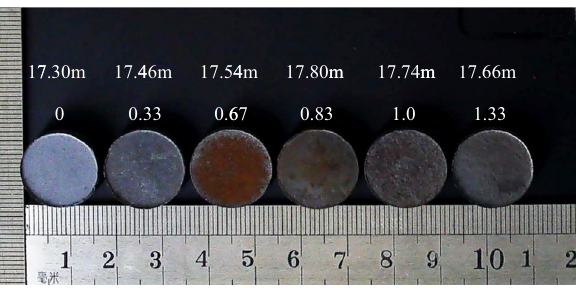
Figure 10: Morphology of reduced briquettes with di ff erent basicity values fi red at 1,300°C and reduction for 60 min.